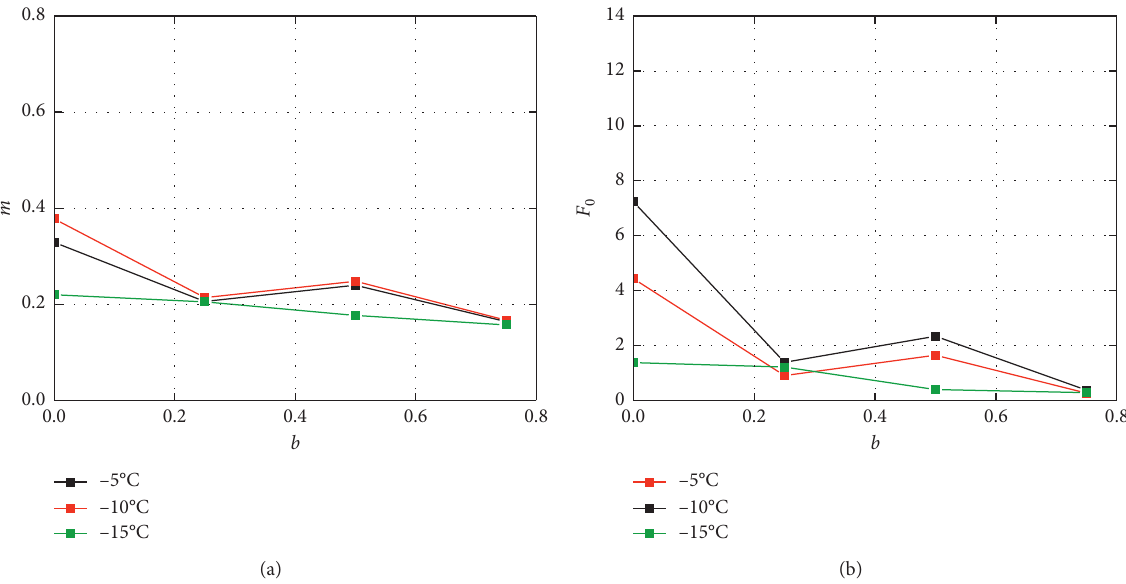
Figure 11: The relationship between the Weibull distribution parameters F 0 and m with b and T . In Figure 11, the linear fitting correlation coefficient R 2 of equation (31) is 0.96, and the linear fitting correlation coefficient R 2 of equation (32) is 0.97. (a) The relationship between parameter m to the temperature T and the middle principal stress coefficient b . (b) Parameter F 0 variations with temperature T and the middle principal stress coefficient b